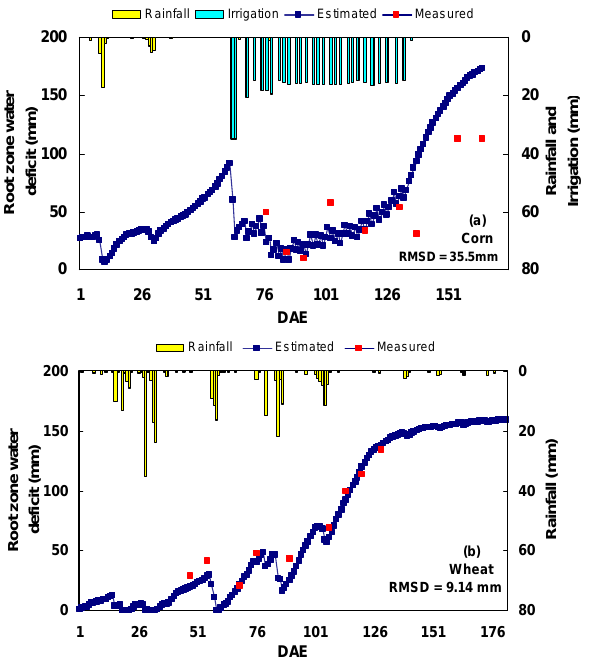
Fig.6 Daily measured and estimated root zone water deficit for corn (2009) (a) and wheat (2009) (b) 22 Fig. 6. Daily measured and estimated root zone water deficit for using a satellite-estimated K cb. (DAE= day after emergence). 23 corn (2009) (a) and wheat (2009) (b) using a satellite-estimated K cb . (DAE=day after emergence).